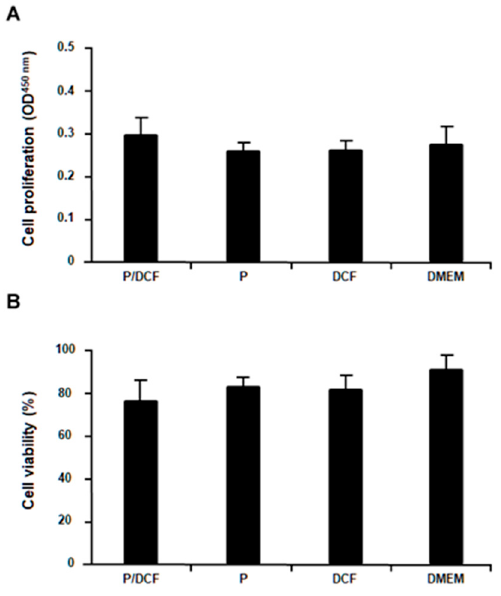
Figure 7. Analysis of cell proliferation and viability of hMSCs treated with the PolyCD-based nanoassemblies (2 mg/mL). hMSCs (2 × 10 4 cells/well in 24-well plates) were directly incubated with the compounds. Cell proliferation was evaluated using the Cell Proliferation Reagent WST-1 ( A ) and cell viability with the Cytotoxicity Detection KitPLUS (LDH) ( B ) after 48 h. Abbreviations: P/DCF: